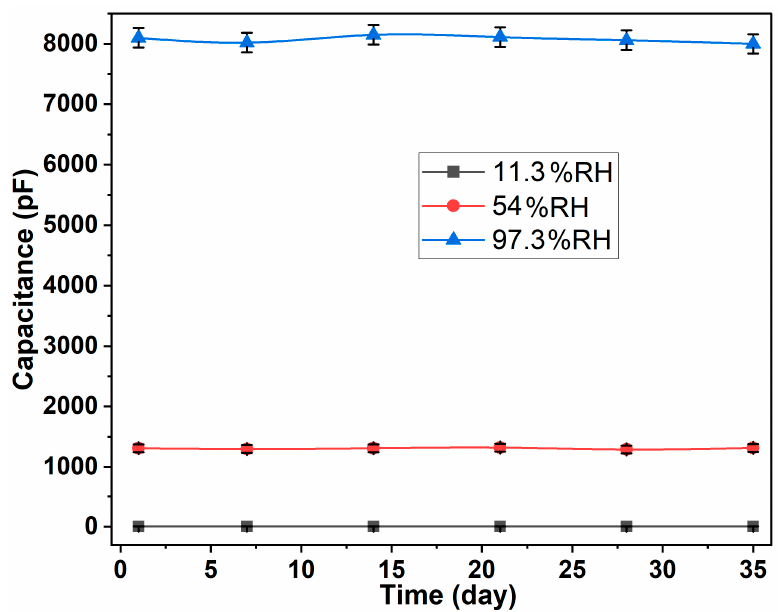
Figure 7. The long-term stability of the proposed sensor for 35 days.